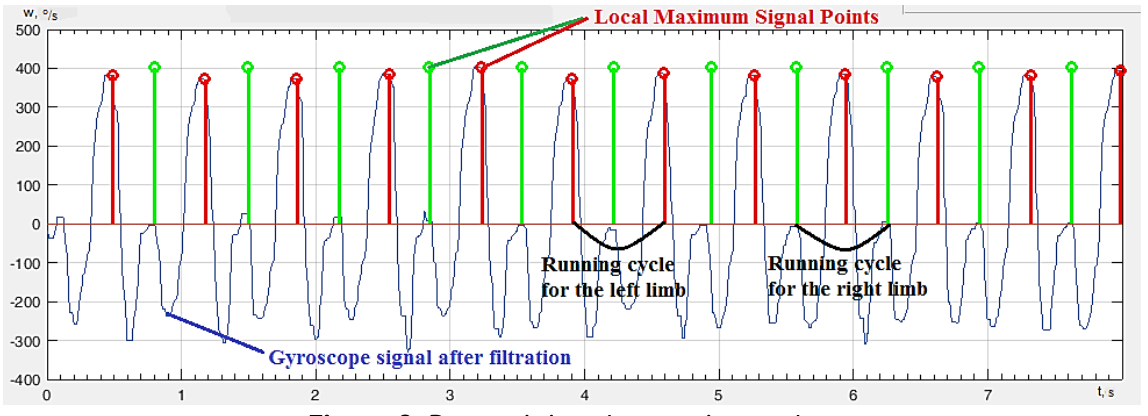
Figure 8 . Determining the running